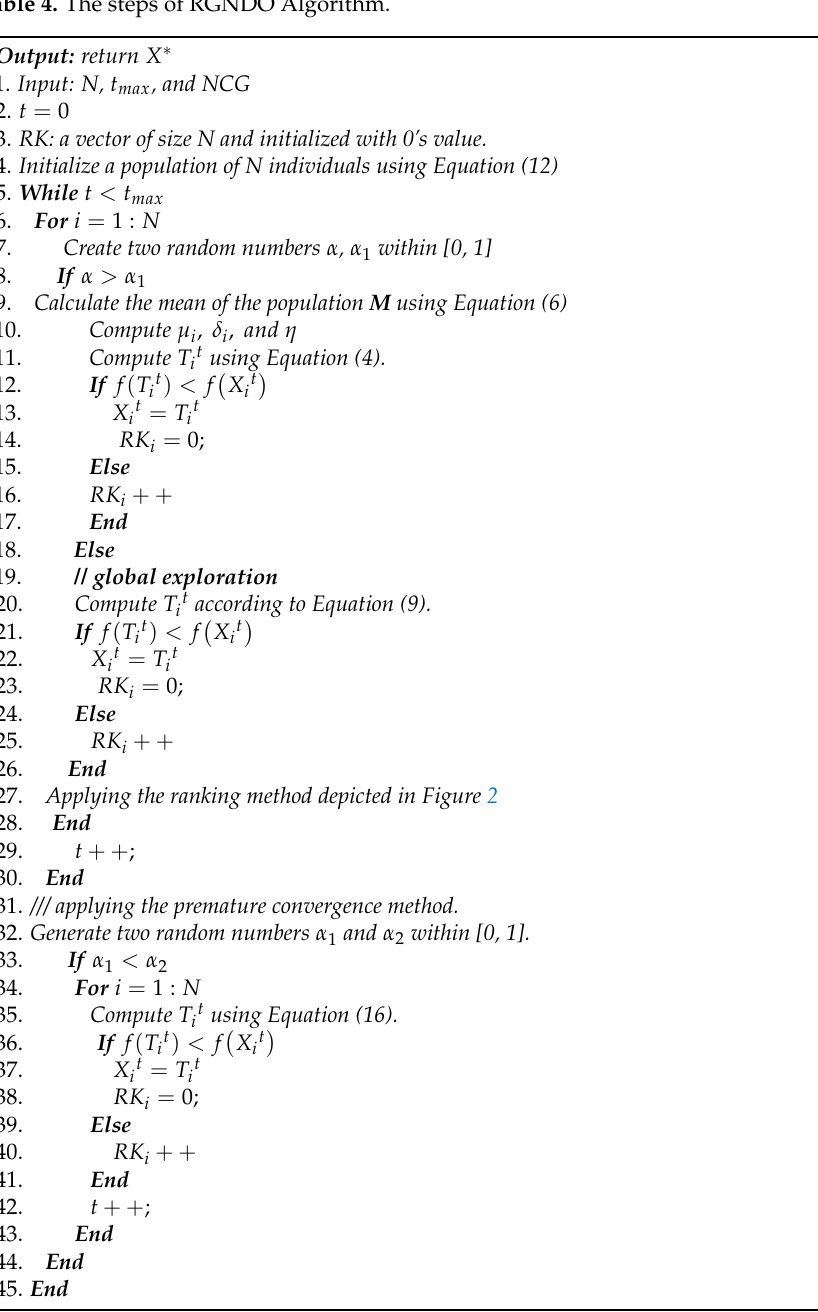
Table 4. The steps of RGNDO